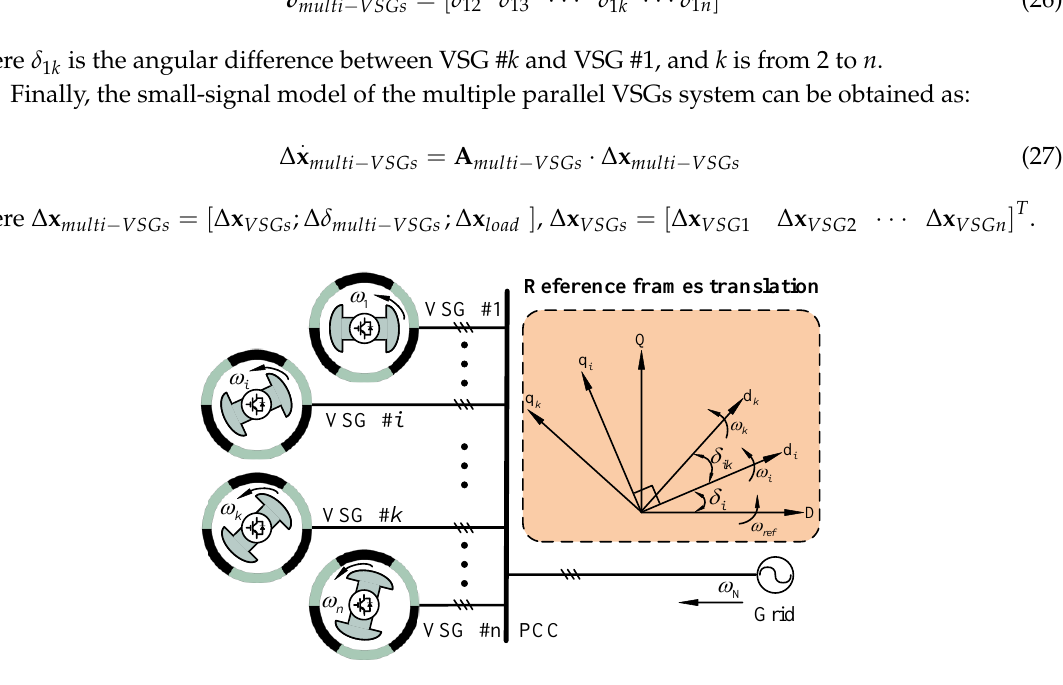
Figure 8. Reference frame transformation.